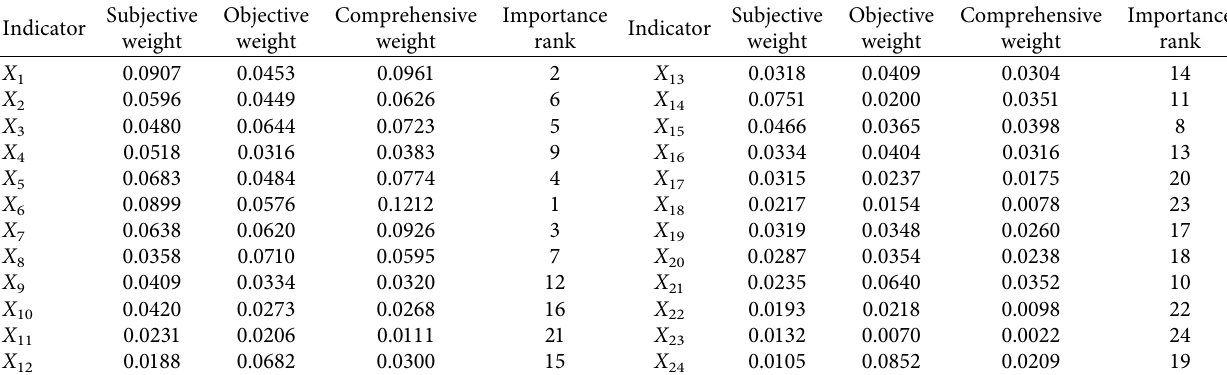
Table 16: The weights of reputation evaluation indicators of IFPs.